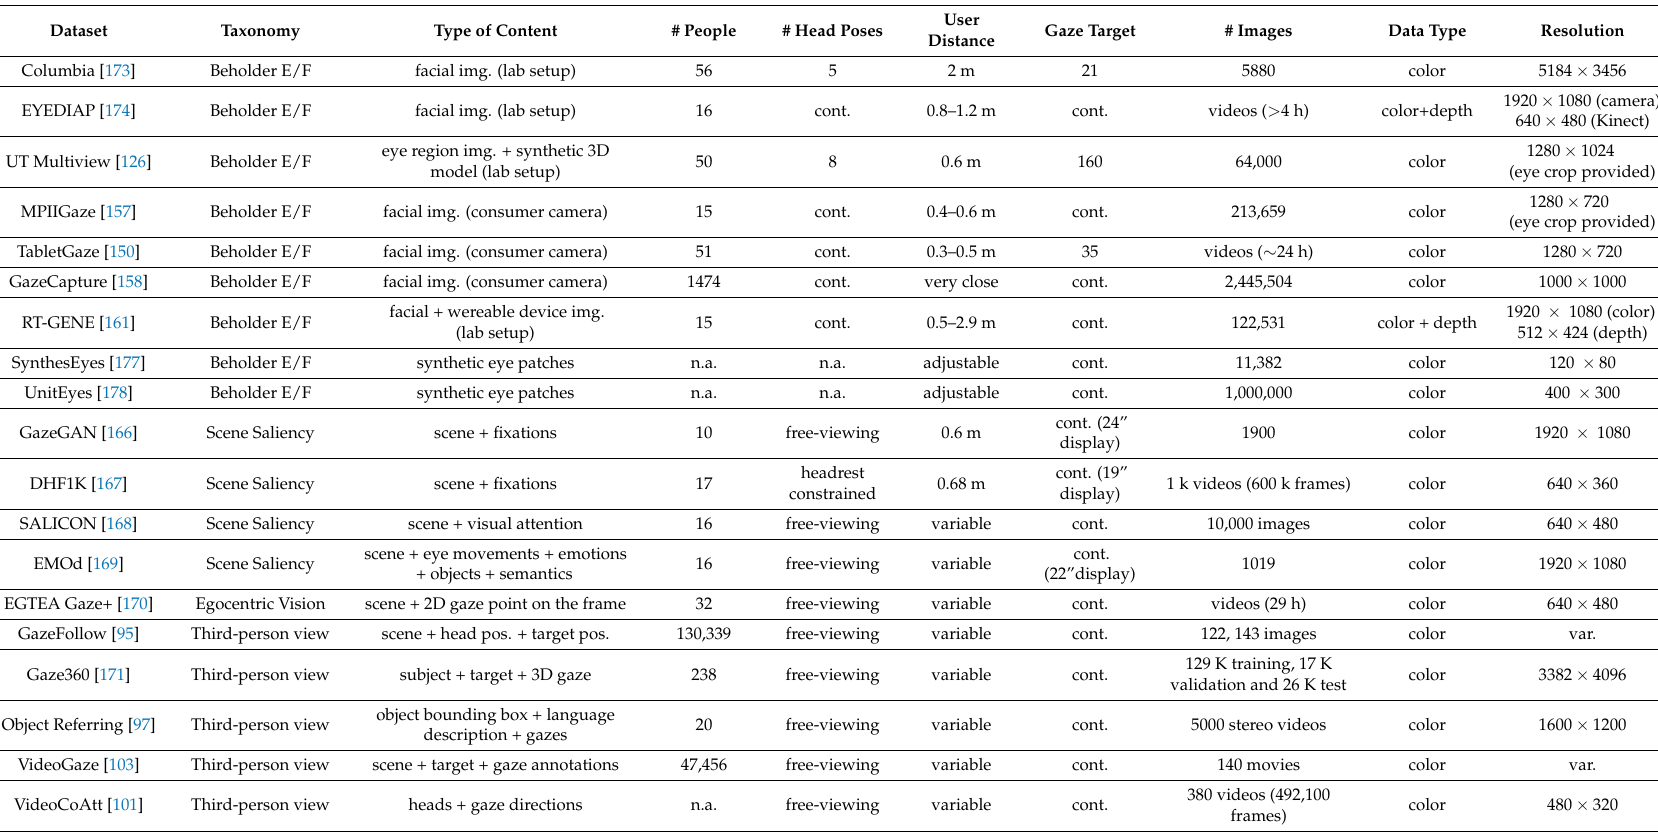
Table 1. A summary of relevant datasets for gaze estimation. cont. stands for continuous, E/F for eye/face, pos. for position, coord. for coordinates, img. for images.